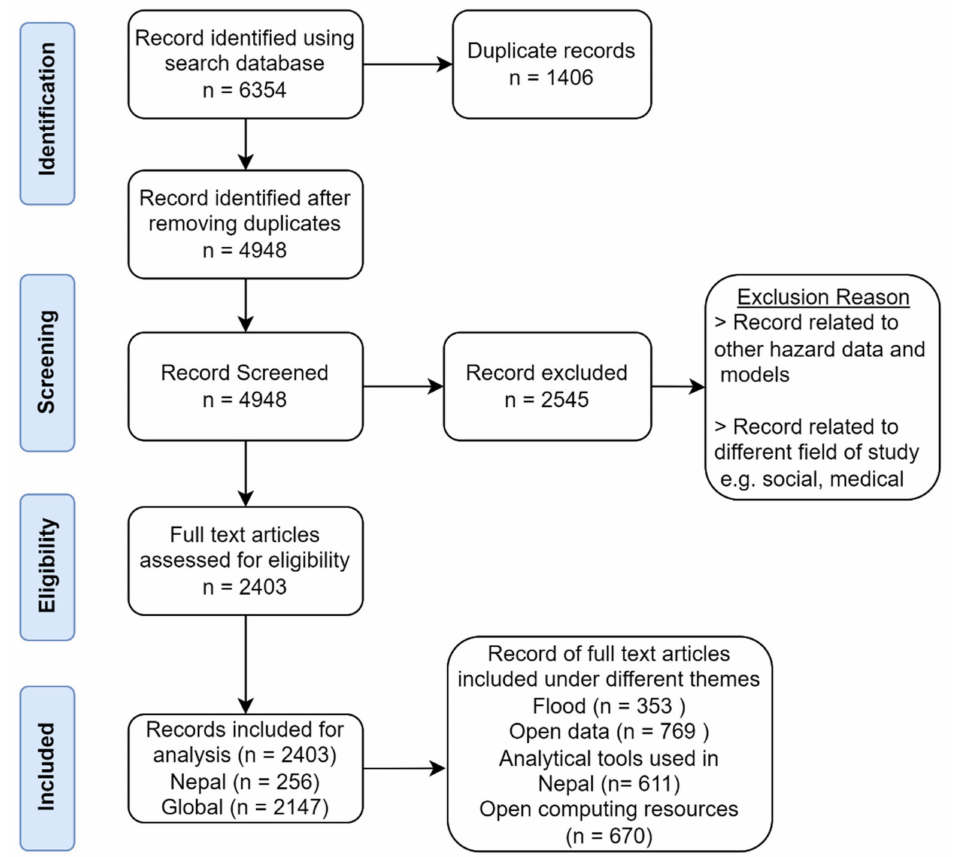
Figure 2. PRISMA flow diagram of the study.